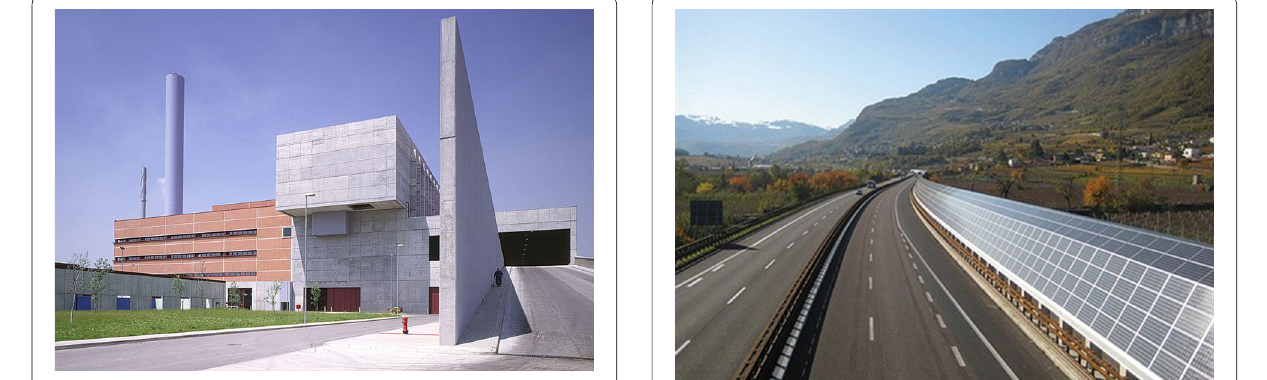
Fig. 12 Waste-to-energy tele-heating system Silla 2 in Milan (from http://www.a2a.it)